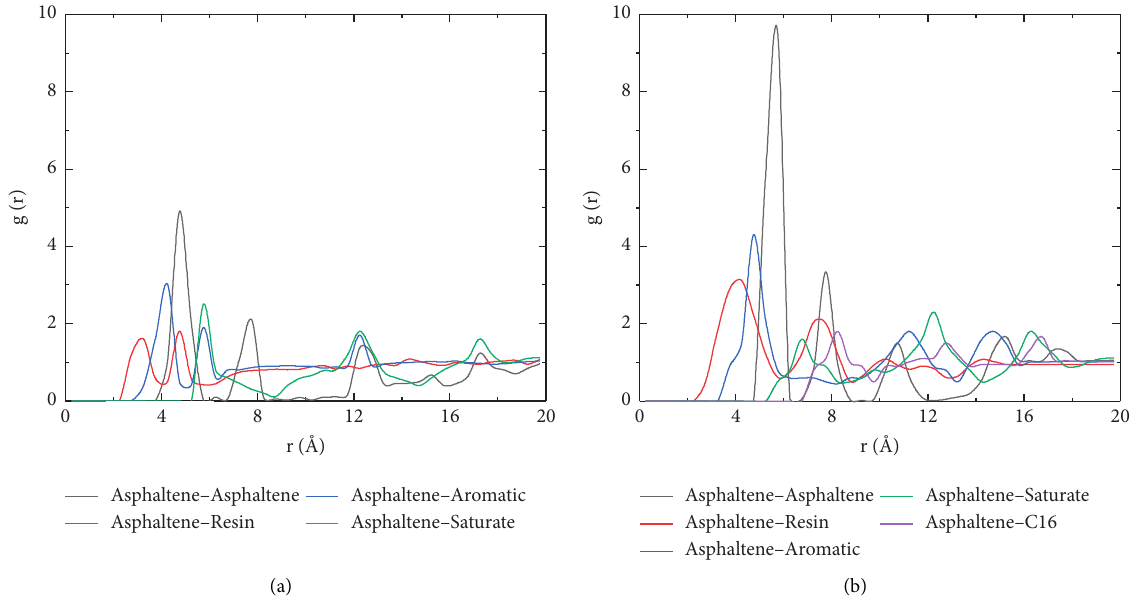
Figure 5: RDF curves of asphaltene with other components. (a) Heavy fuel oil. (b) Low-sulfur fuel